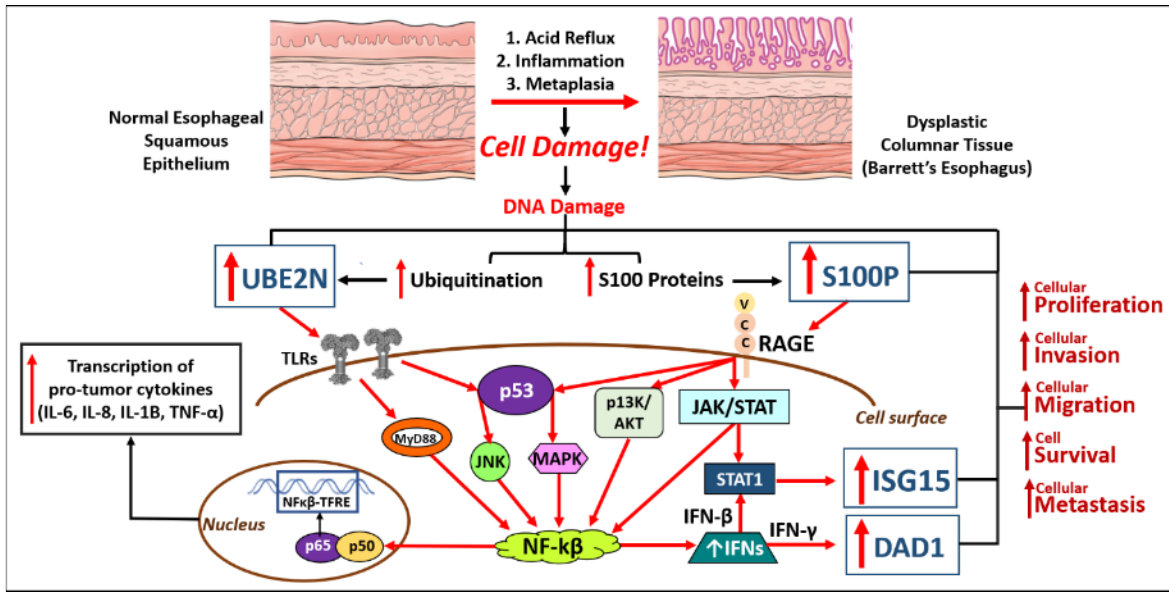
Figure 2. Biochemical malignant transformation of distal esophageal compartment during the chronic acidic assault. UBE2N and S100P are upregulated during the body’s well-intentioned response to repair cell damage in the distal esophagus mucosa, leading to unfavorable pro-tumoral processes. It should be noted that these proposed interconnecting pathways have been assembled from over a dozen references and should be considered mostly hypothetical, with the hope of future experiments to further elucidate and confirm the mutual intersections and oncogenic mechanisms of these four markers during esophageal adenocarcinoma pathogenesis. UBE2N (ubiquitin-conjugating enzyme E2 N), RAGE (receptor for advanced glycation end products), IL (interleukin), TNF- α (tumor necrosis factor-alpha), NF- κB (nuclear factor kappa beta), MyD88 (myeloid differentiation primary response 88), JNK (c-Jun N-terminal kinases), MAPK (mitogen-activated protein kinases), PI3K (phosphoinositide 3-kinases), AKT (protein kinase B), IFN- γ (interferon gamma), JAK (Janus kinase), STAT (signal transducer and activator of transcription), ISG15 (interferon-stimulated gene 15), DAD1 (defender against cell death 1).